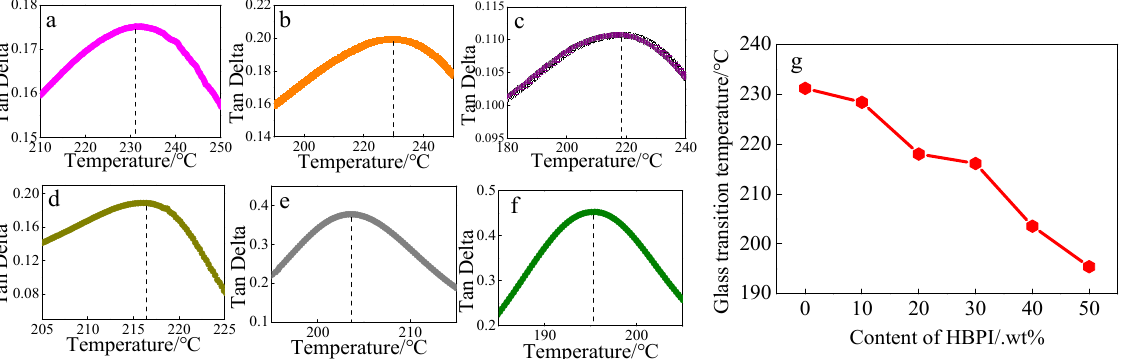
Figure 6. The DMA results of BMI and modified BMI with HBPI. ( a – f ) Neat BMI and modified BMI with 10%, 20%, 30%, 40%, 50% amount of HBPI, ( g ) Changing trend of Tg of modified BMI with different HBPI content.